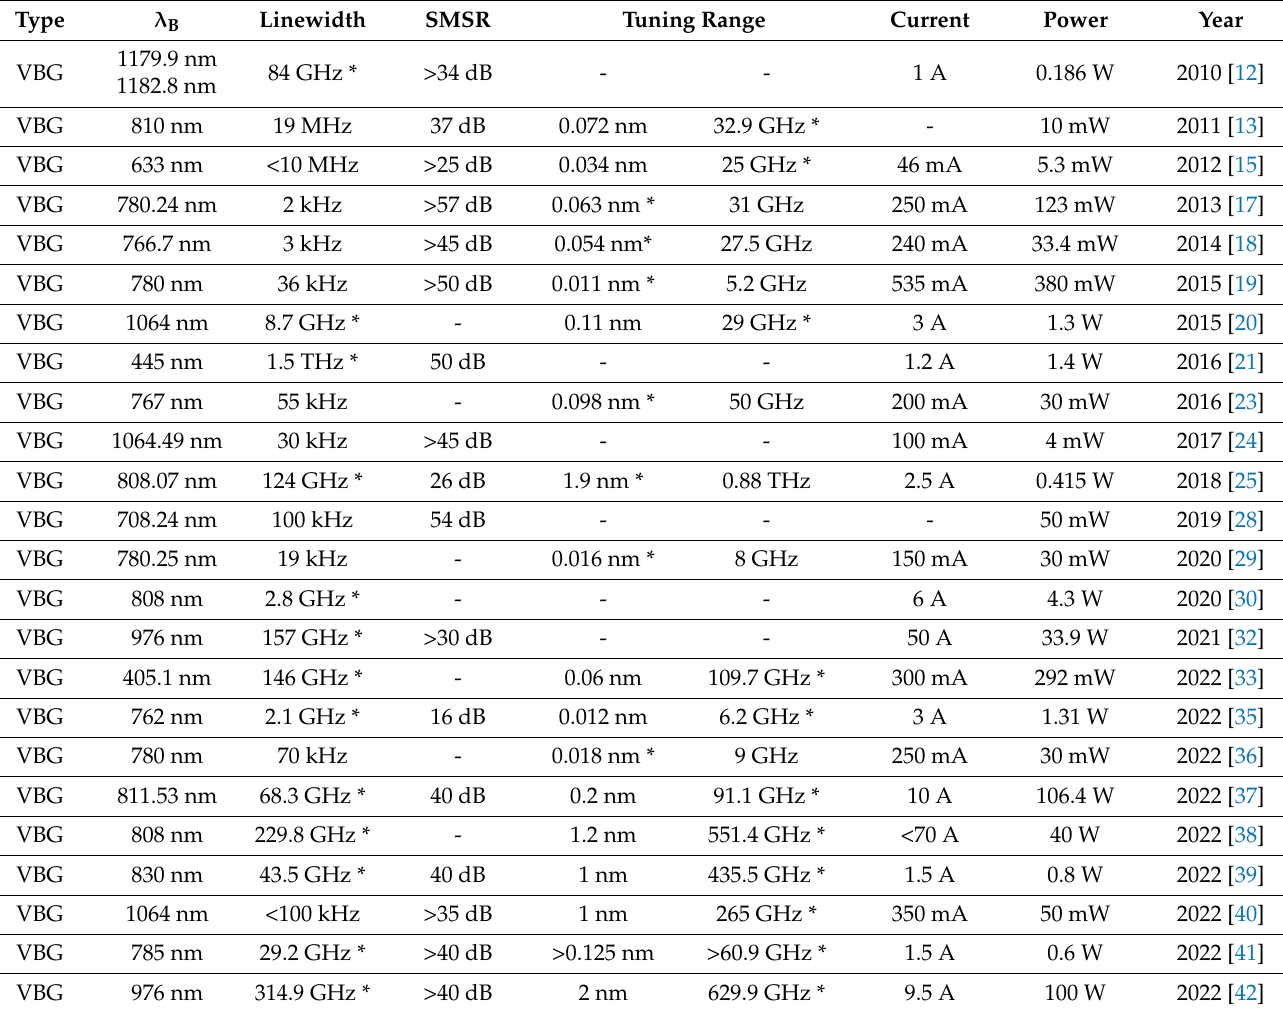
Table 1. The performances parameters of